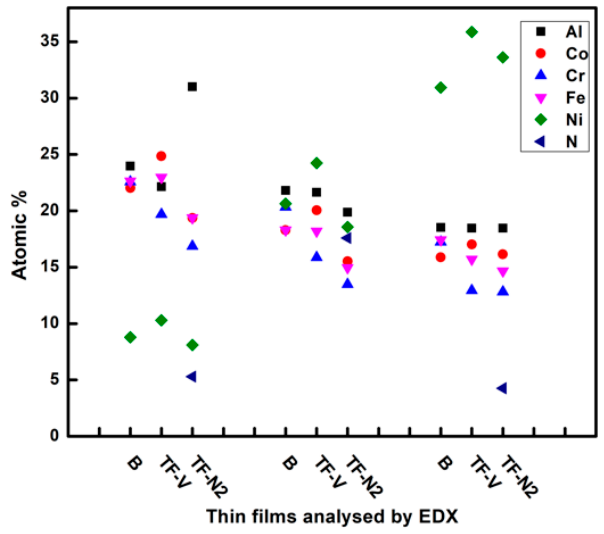
Figure 6. Plotted data on chemical elemental composition measurements by EDX of all HEAs bulk SS, and corresponding thin HEAs as well as HENs films of nickel concentration 0.4, 1.2, and 2.0. B stands for bulk, TF-V for thin HEA films, and TF-N2 for thin HEN films.